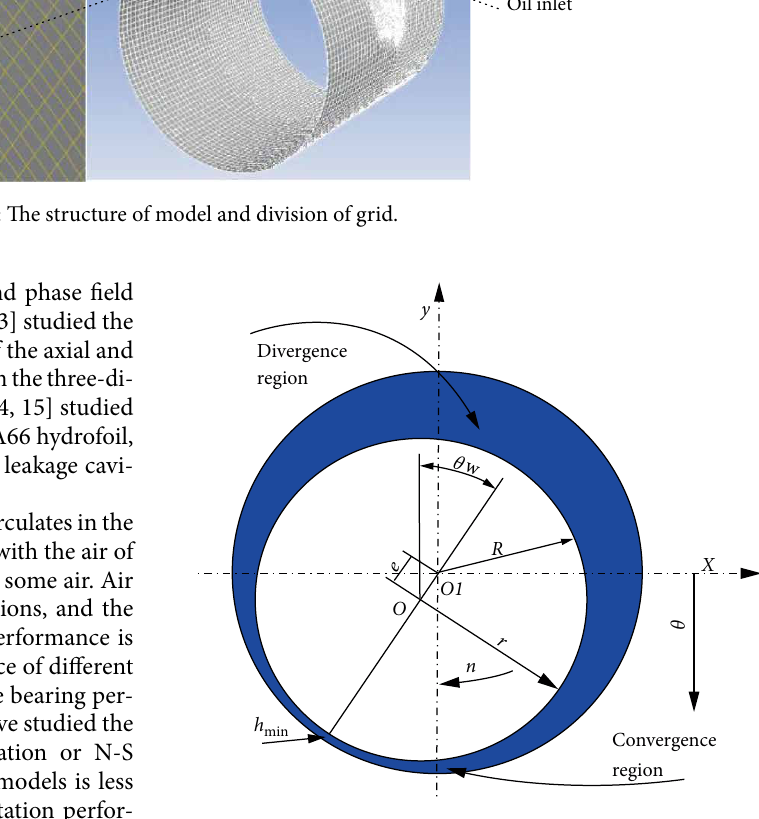
Figure 2: The geometrical structure of journal